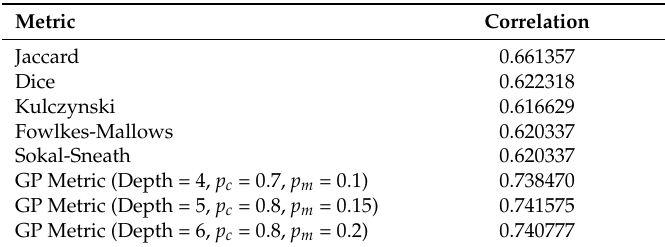
Table 1. Correlation results.